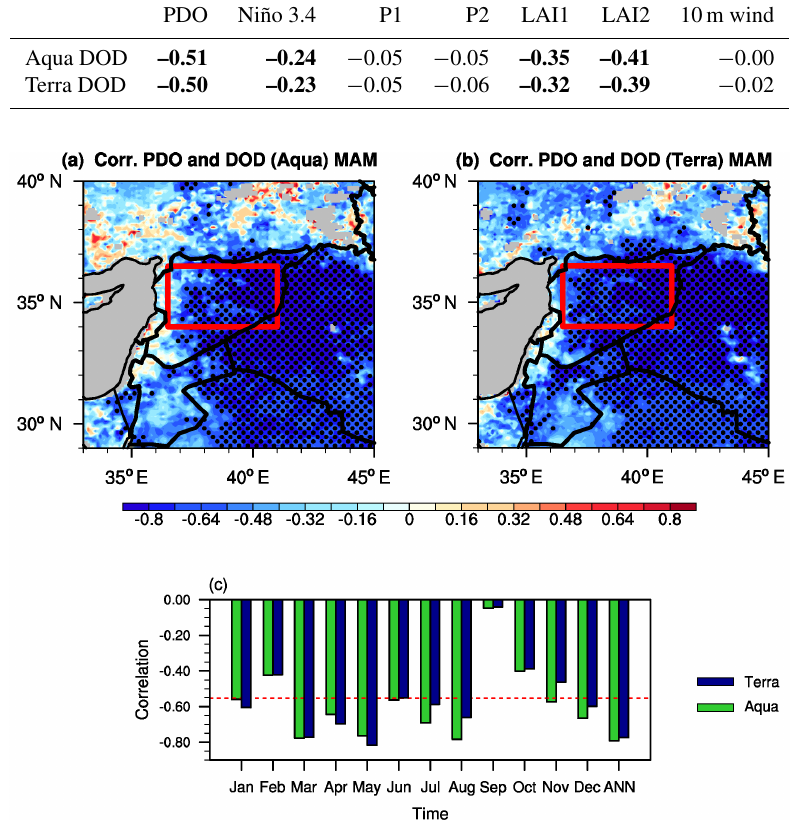
Figure 2. Correlation between the PDO index and MODIS (a) Aqua and (b) Terra DOD in MAM from 2003 to 2015. (c) Correlation between Syrian DOD indices (navy and green bars denote Terra and Aqua, respectively) and PDO index for each month and annual mean (ANN) from 2003 to 2015. Red dashed lines denote the 95% confidence level ( t test). Red box denotes the averaging area for Syrian DOD